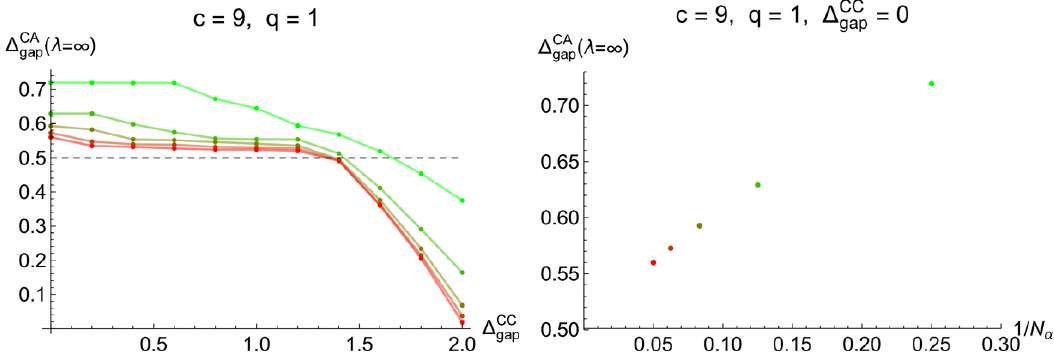
Figure 13. Left: upper bounds on the gap in the CA channel (cid:1) CA as a function of the gap in the CC channel (cid:1) CC in the case of c = 9 and q = 1, at derivative orders 4, 8, 12, 16, 20. Right: the bounds (cid:1) CA (cid:21) = and (cid:1) CC = 0 plotted over inverse derivative order hints at a convergence towards (cid:1) CA gap 1